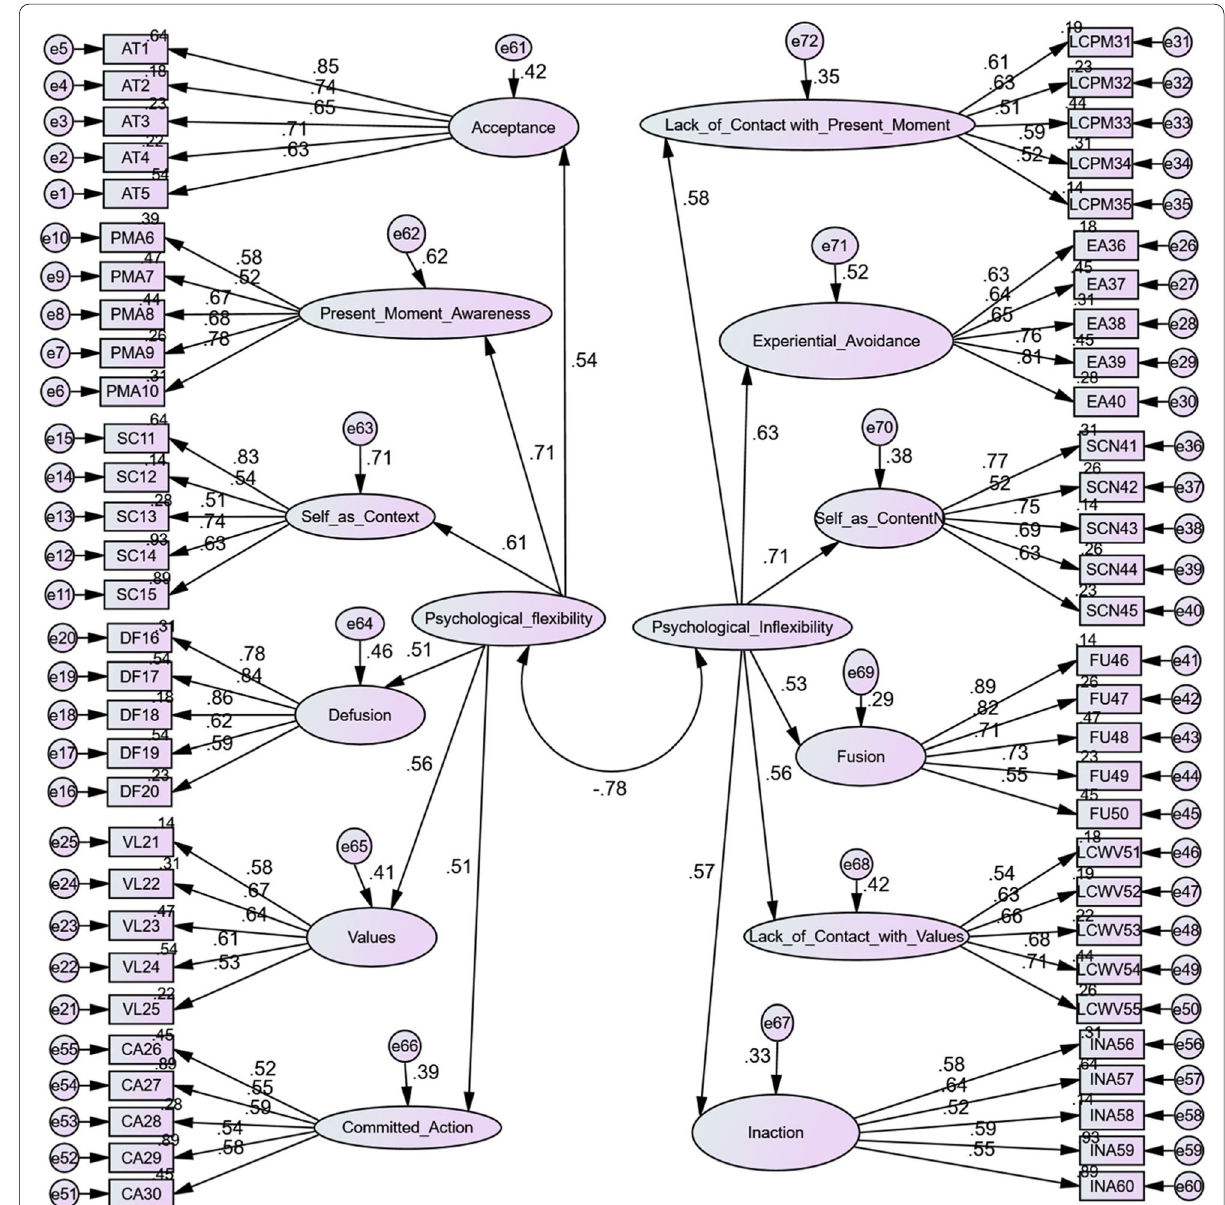
Fig. 1 Confirmatory factor analysis with factor loadings for the twelve subscales of the psychological flexibility and psychological inflexibility ( p < 001). All factor loading values were greater than the cutoff score 0.5. The results of the measurement model fit assessment showed that the fit indices met the cutoff values (CMIN/df